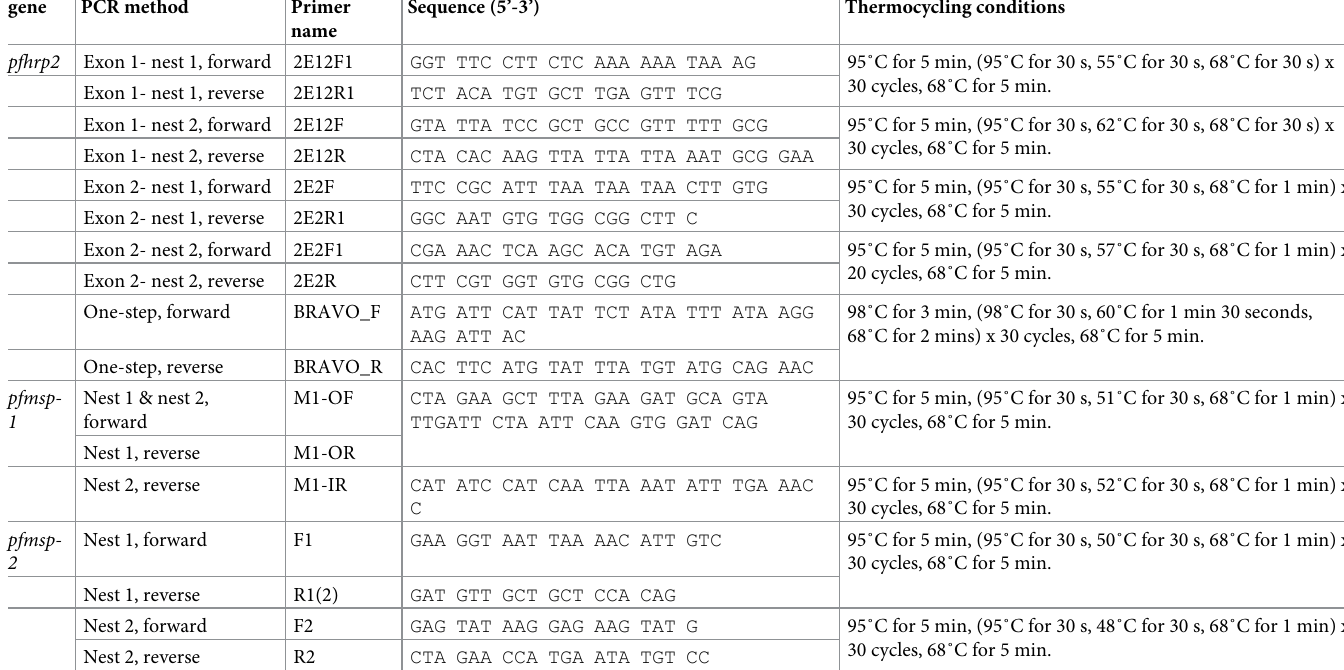
Table 1. PCR primer sequences and thermocycling